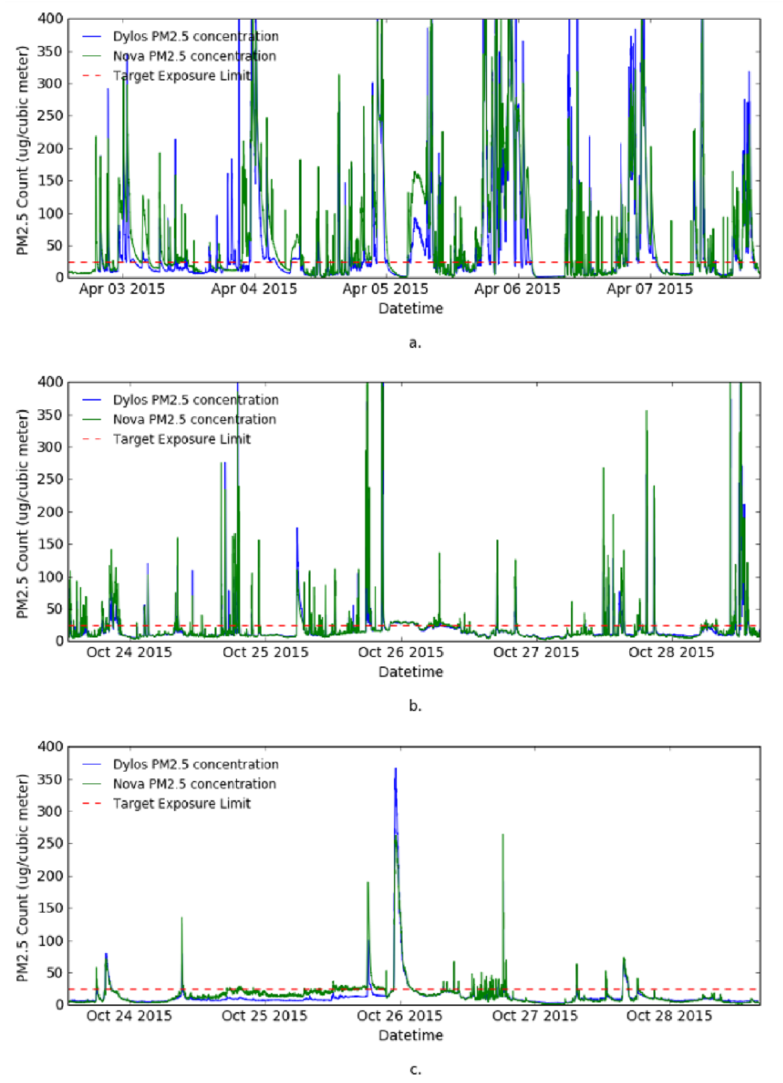
Figure 4. Line graph of raw sensor observation from the monitored sites. ( a ) Site 1; ( b ) Site 2; and ( c ) Site